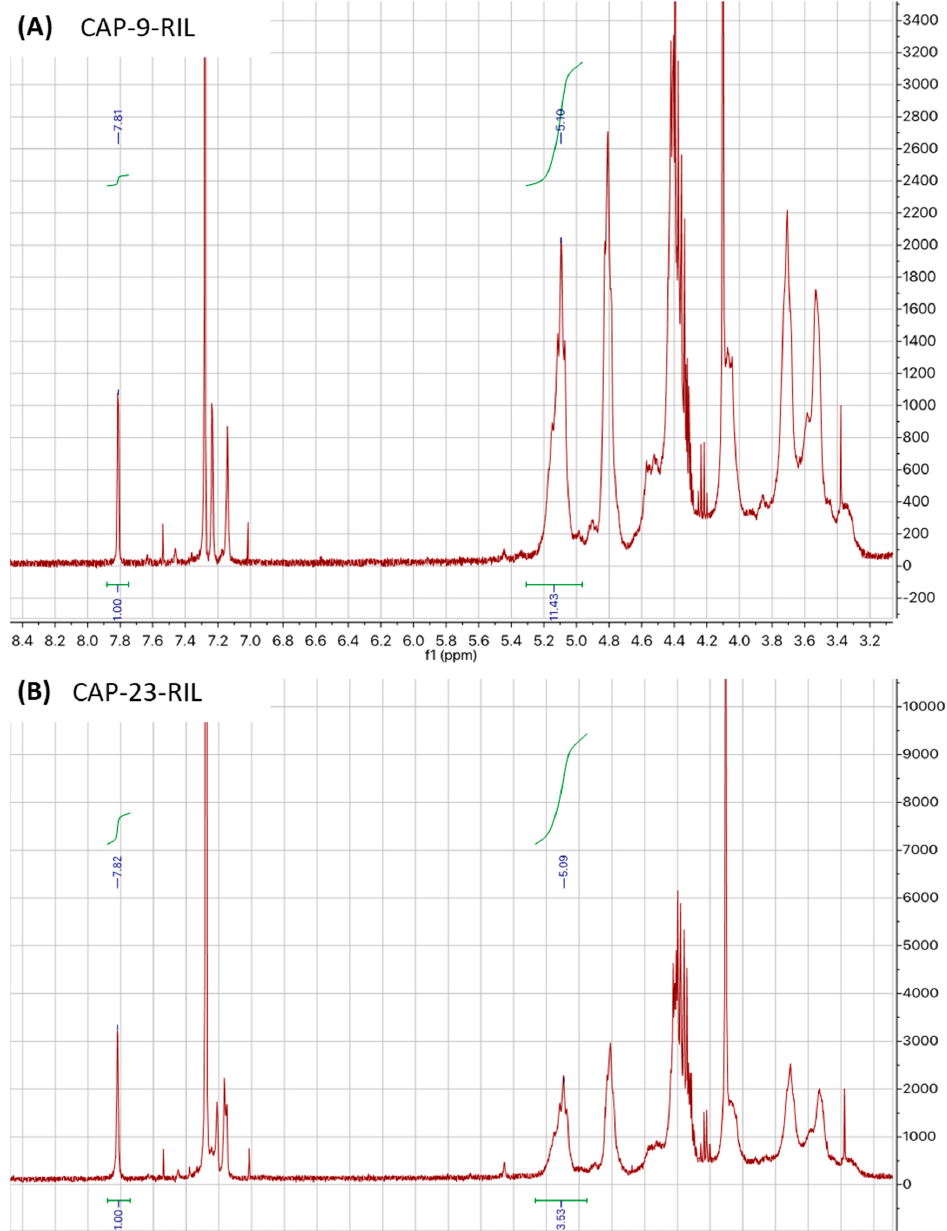
Figure 8. 1H NMR spectra of ( A ) CAP-9-RIL; and ( B ) CAP-23-RIL membranes.